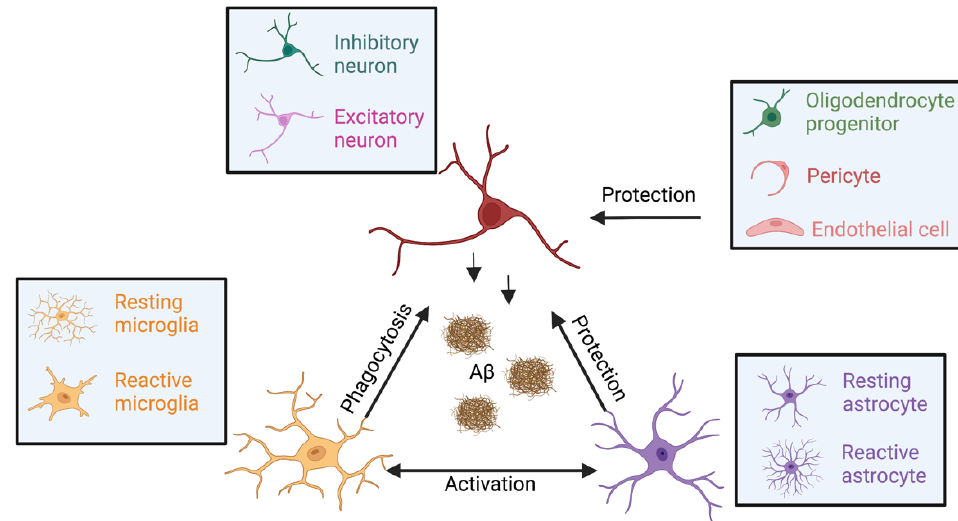
Figure 3. The crosstalk between neurons and non-neurons.